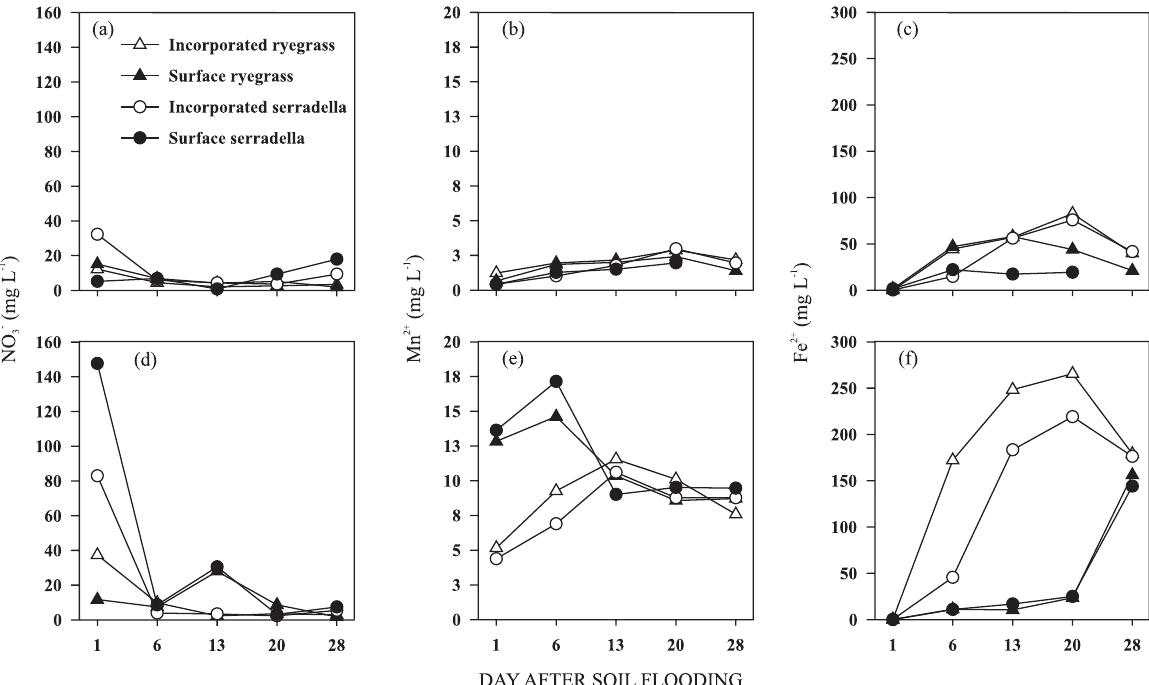
Figure 3. Concentration of nitrate (NO 3- ), manganese (Mn 2+ ) and iron (Fe 2+ ) in the solution of a flooded Albaqualf at depth of 2 (a, b, c,) and 20 cm (d, e, f) affected by the residue management (incorporated or left on the soil surface) of ryegrass and